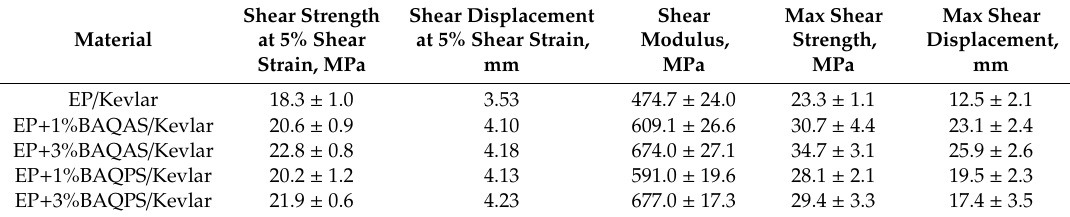
Table 3. Results of the in-plane shear test on ( ± 45) laminates 1 .